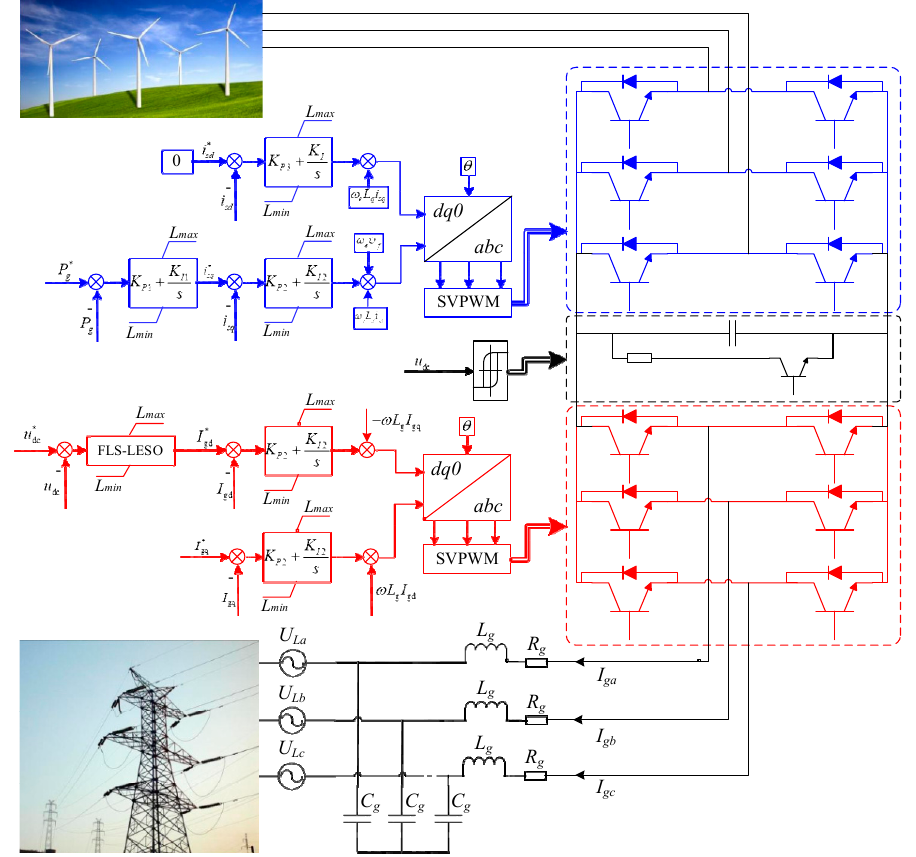
Figure 2. Topology and control structure of wind energy conversion system.